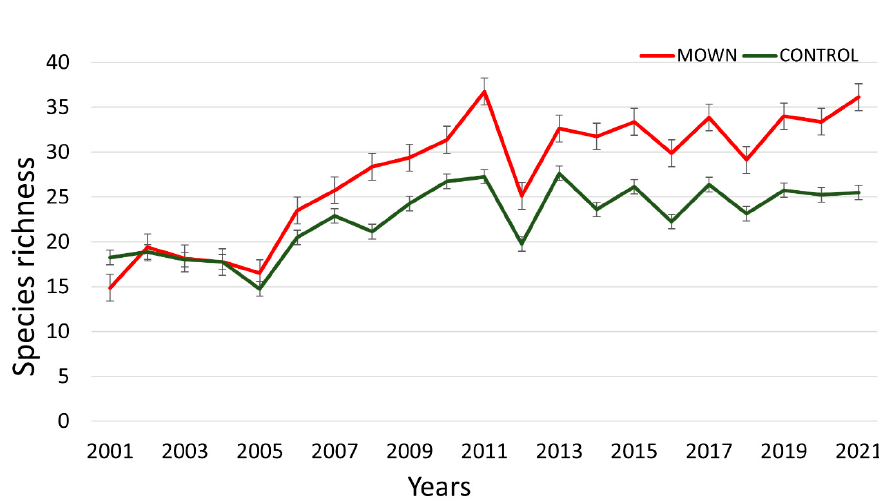
Table 4. Results of repeated measures ANOVA of species richness . Asteriks indicate statistical significance. Figure 3. Average species richness in mown and control plots with standard errors during the study period.